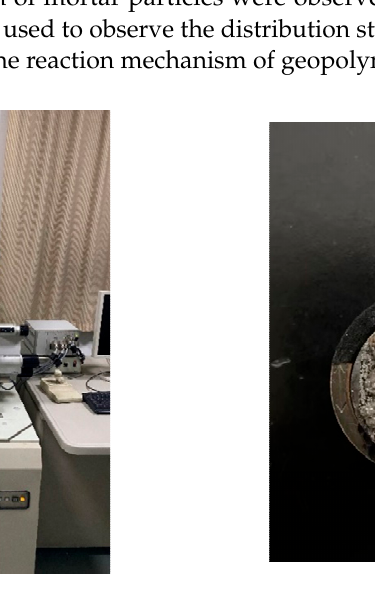
Figure 4. Scanning electron microscope and cube